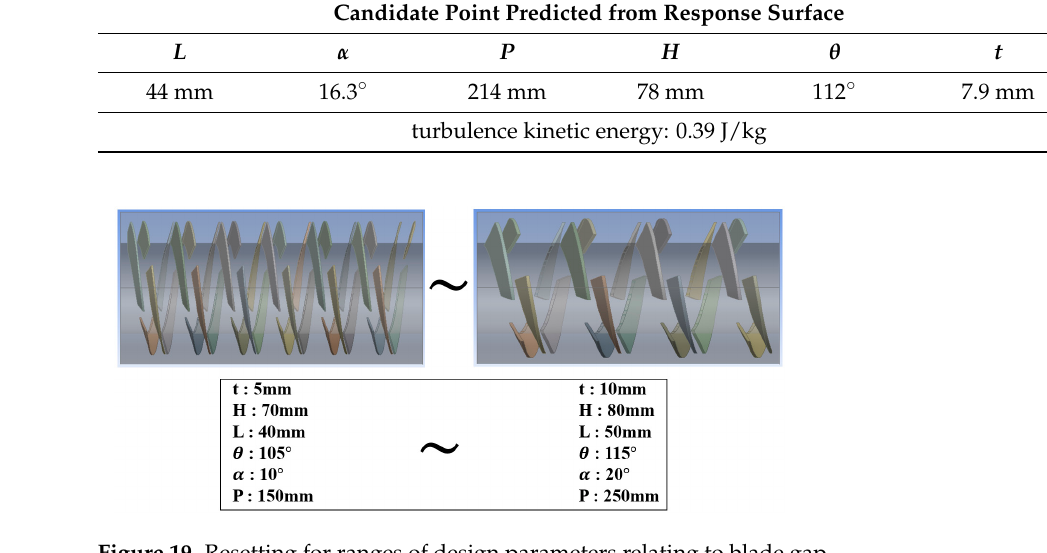
Table 6. The result obtained from response surface.